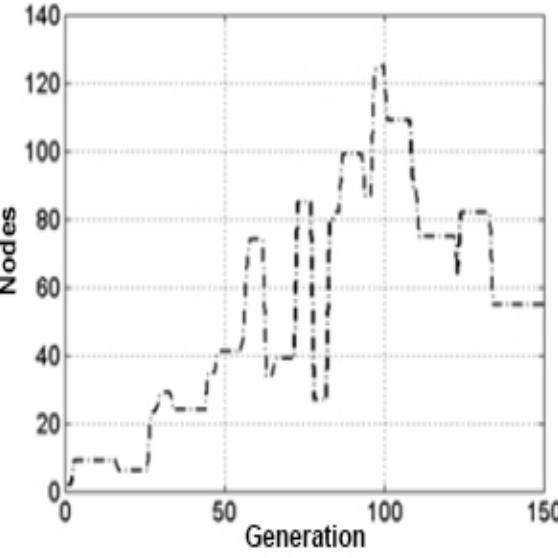
Figure 6. Result of the Tic Tac problem objective